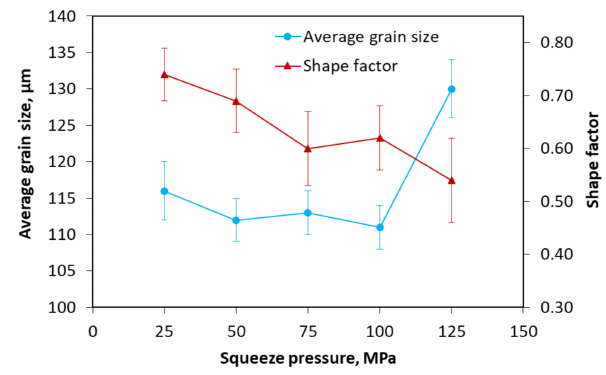
Figure 9. E ff ects of squeeze pressure on the average grain size and shape